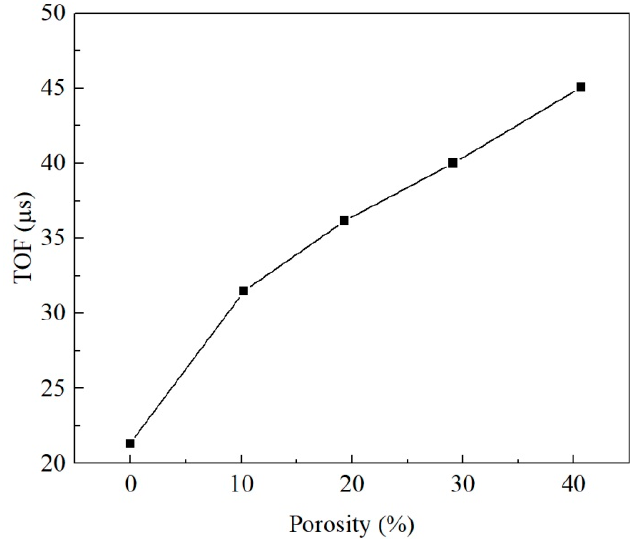
Figure 15. Relationship between porosity and time of flight (TOF). Table 6. Macro dynamic response of porosity.